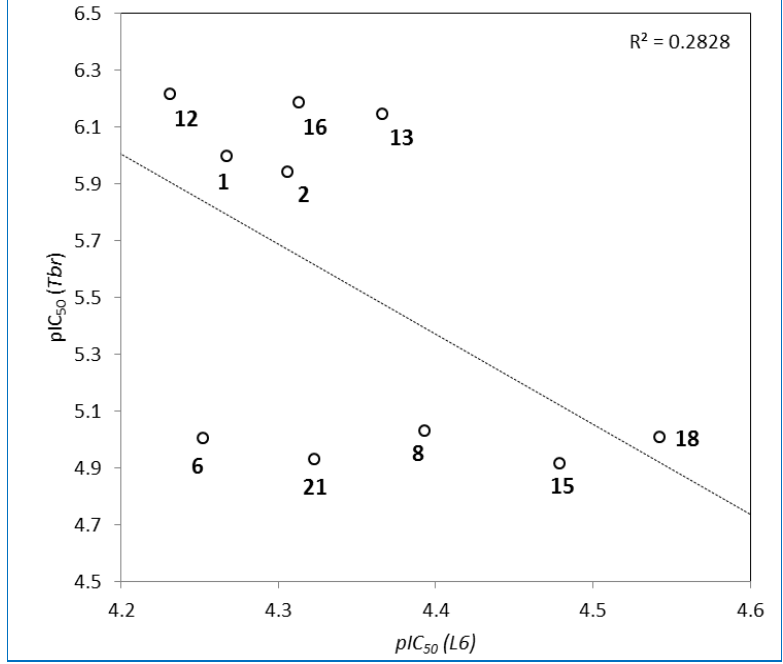
Figure 2. Plot of anti-trypanosomal activity vs. cytotoxicity as pIC 50 [=−log (IC 50 )] data of compounds 1 , 2 , 6 , 8 , 12 , 13 , 15 , 16 , 18 and 21